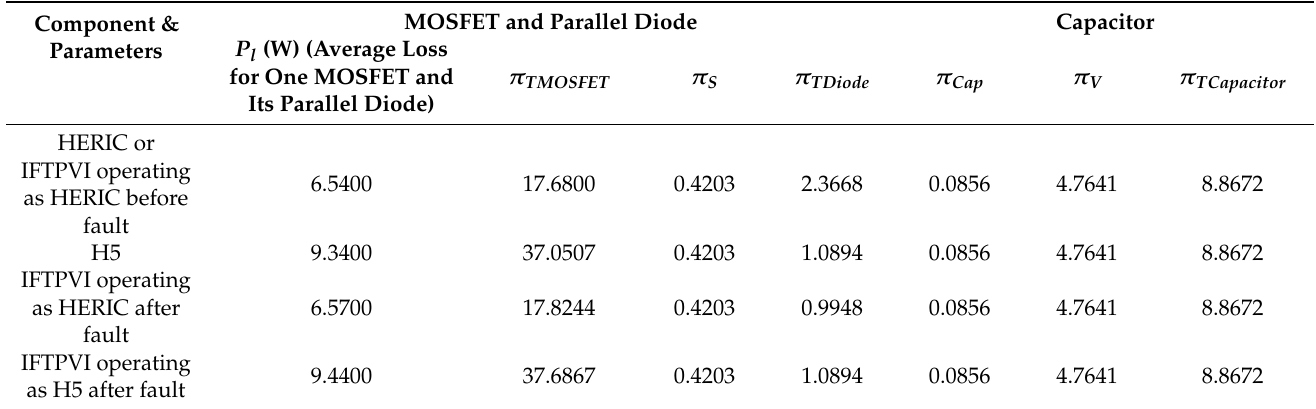
Table 6. Numerical Values Necessary for Effective Parameters on Failure Rates.